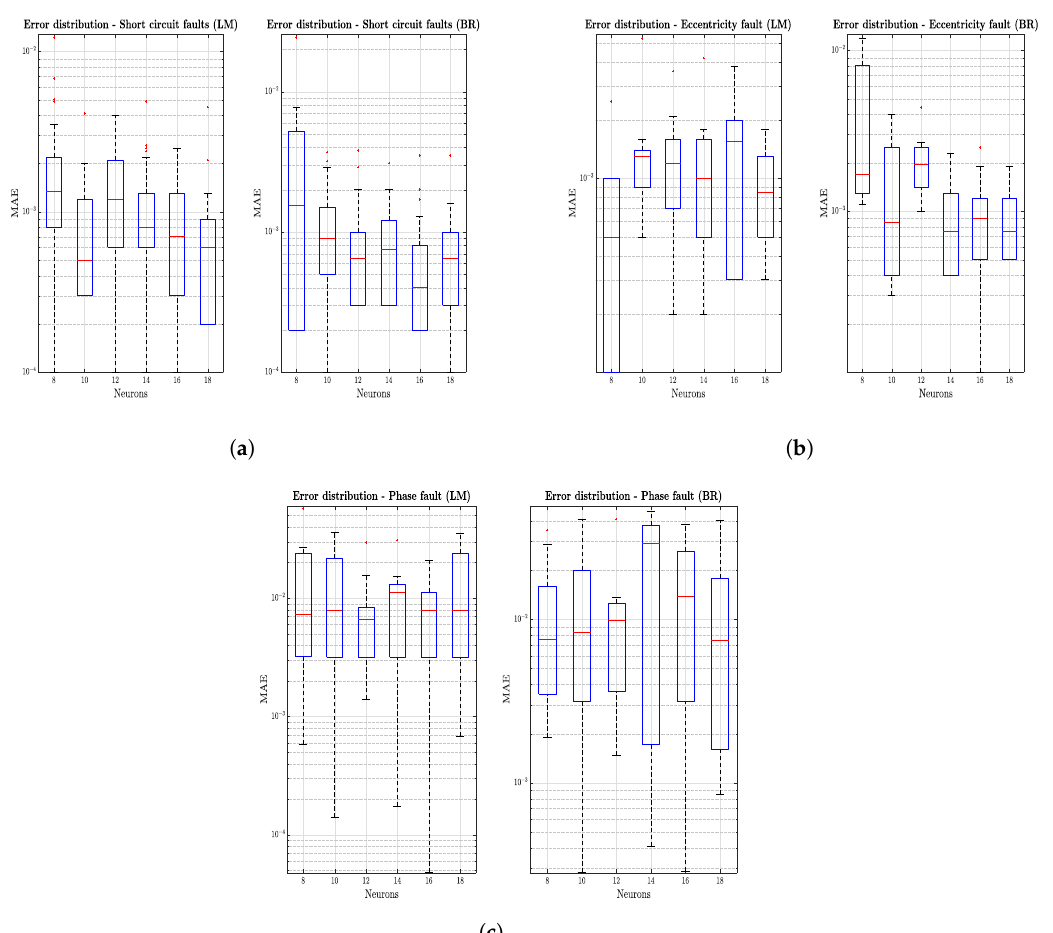
Figure 14. Distribution of the mean absolute error (MAE) on the identification of the considered fault modes, for increasing number of neurons in the layer. Errors were determined for a custom identification set, randomly sampled in the acceptable range defined by Equations (2) and (3). ( a ) Short circuits. ( b ) Eccentricity. ( c )